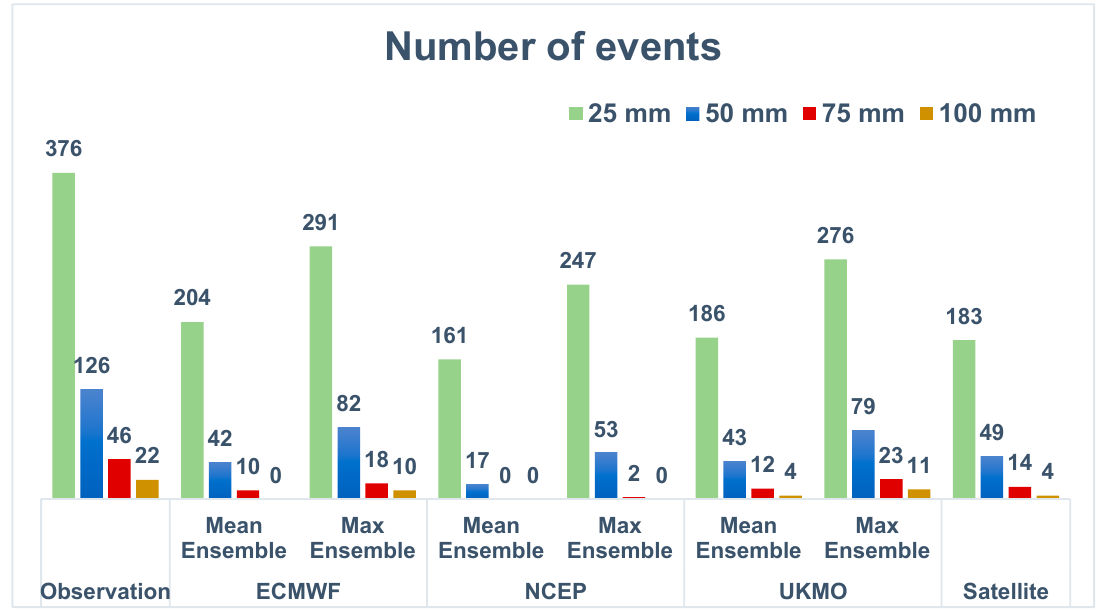
Figure 8. Comparison of the number of extreme events estimated by the NWP models and IMERG satellite with observations in different precipitation thresholds.